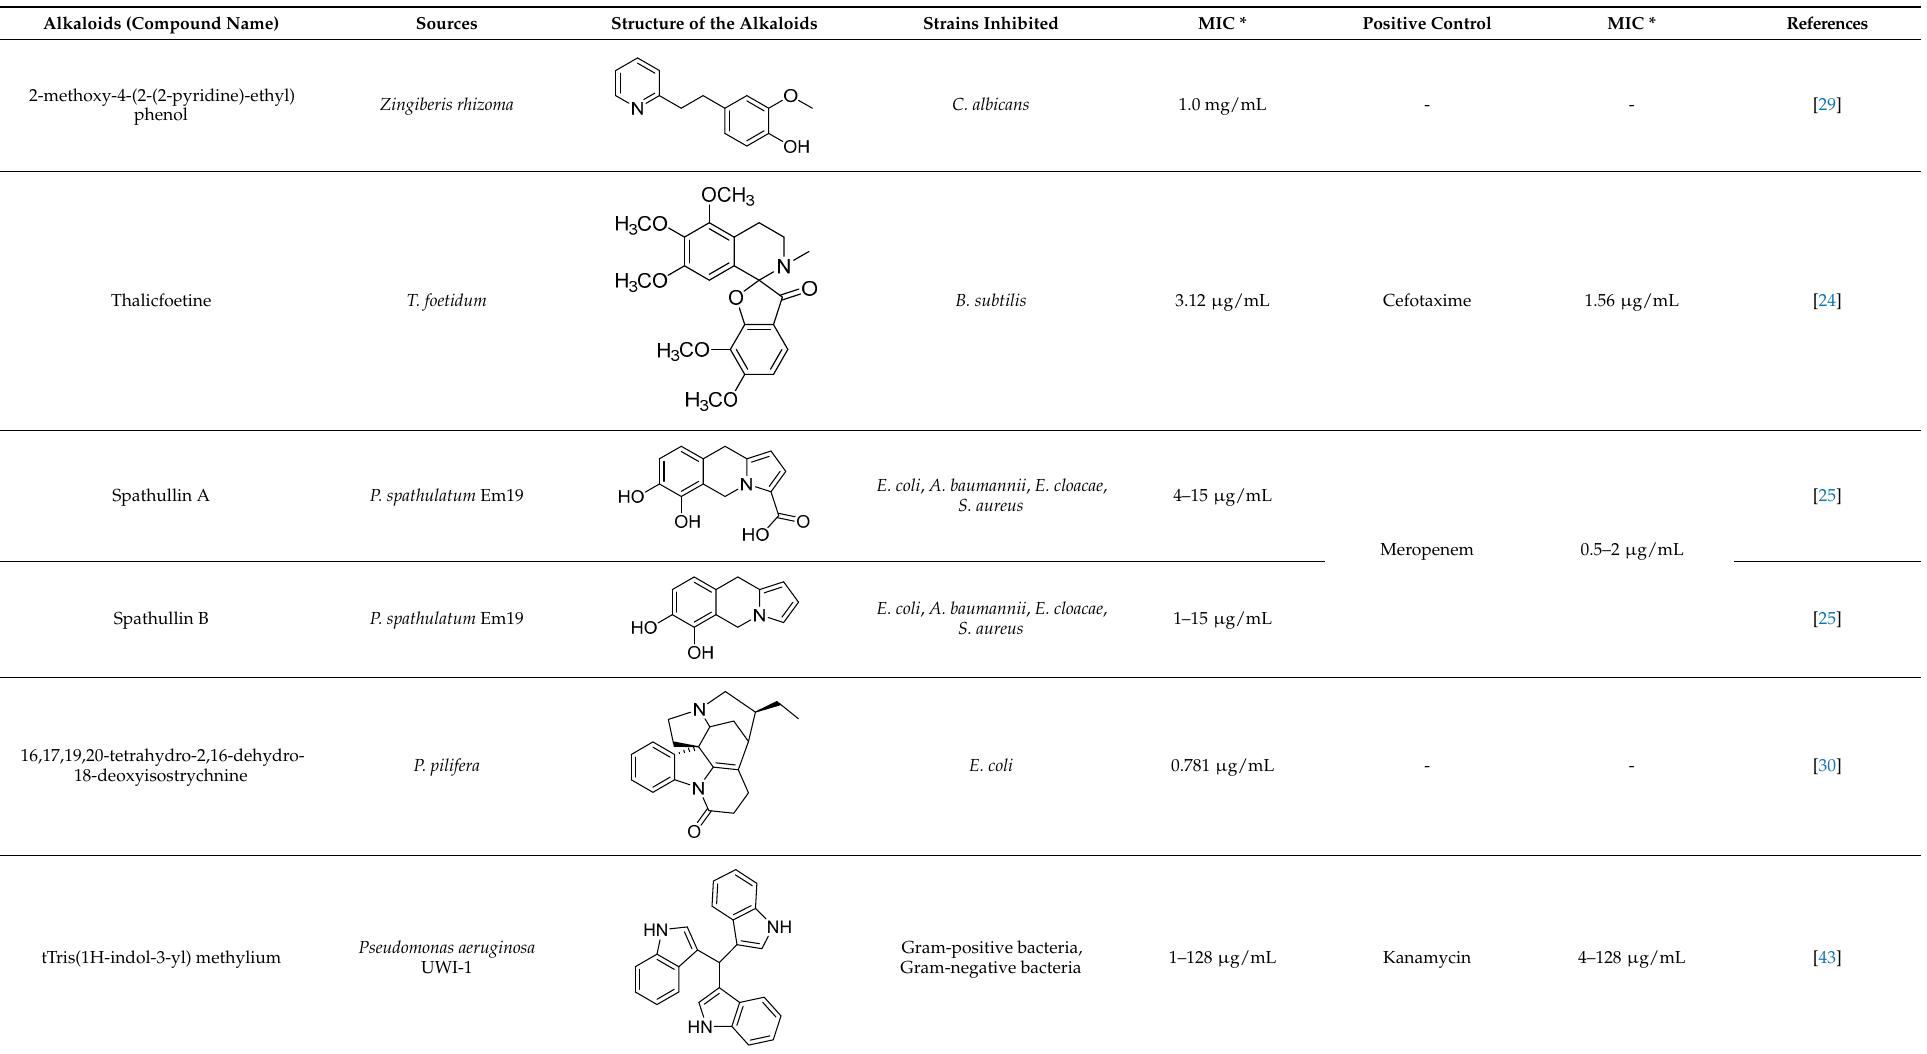
Table 1. Antibacterial activities of natural alkaloids.